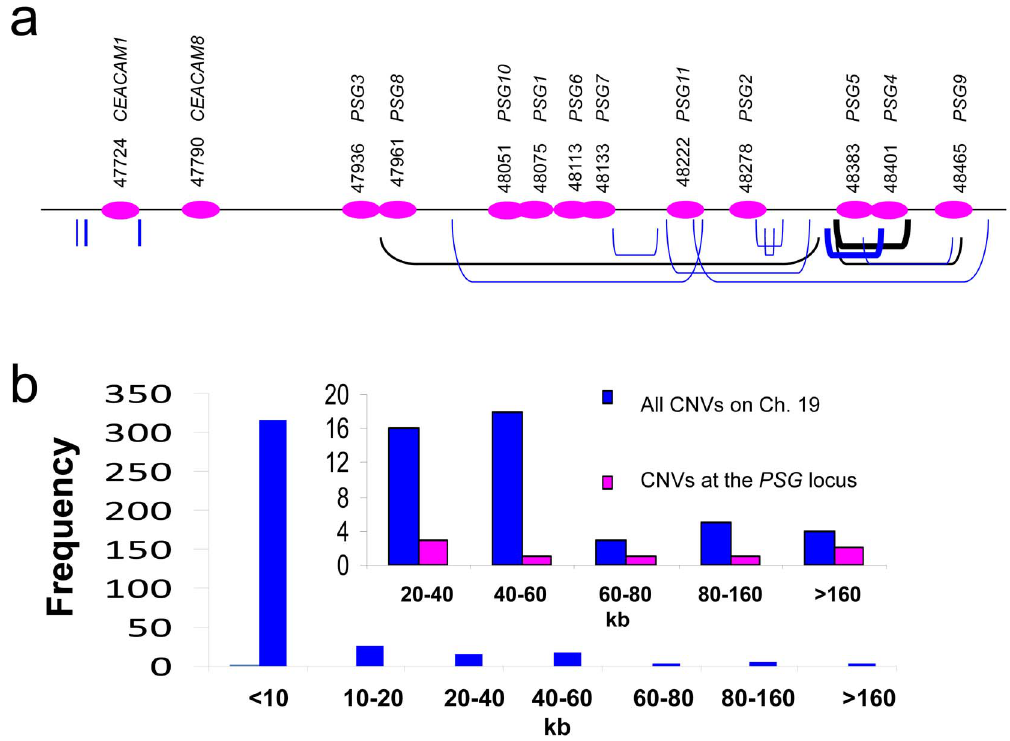
Figure 5. The human PSG locus exhibits frequent copy number variation (CNV). a) Schematic representation of CNVs found at the human PSG locus on chromosome 19 (47,600–48,500 kb) based on studies using high-density probes and DNA sequencing [51,52,53]. CNVs that were identified in CEU (U.S. residents with northern and western European ancestry, N=20) and YRI (Yoruba from Ibadan in African, N=20) populations are indicated by blue brackets under the chromosome. CNVs that were identified in Asian populations (Chinese, Japanese, and Koreans; N=30) are indicated by black brackets. CNVs that have a frequency higher than 50% are indicated by bold brackets. b) The size distribution of 387 unique chromosome-19 CNVs that have a length greater than 500 bp. The figure in the inset shows the distribution of long fragment CNVs (46 in total have